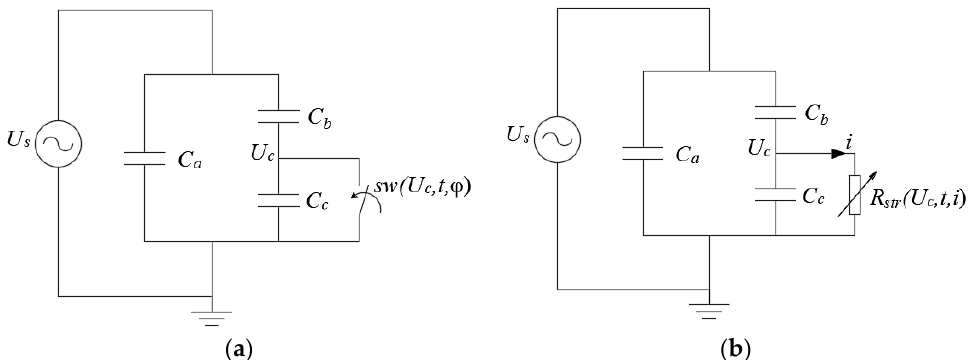
Figure 5. PD three capacitance equivalent circuit: ( a ) PD simulation using a switch in parallel to C c . The switch is controlled using voltage, phase and time as variables; ( b ) PD simulation using a variable resistance in parallel to C c . The value of the resistance is controlled using voltage, current and time as variables.